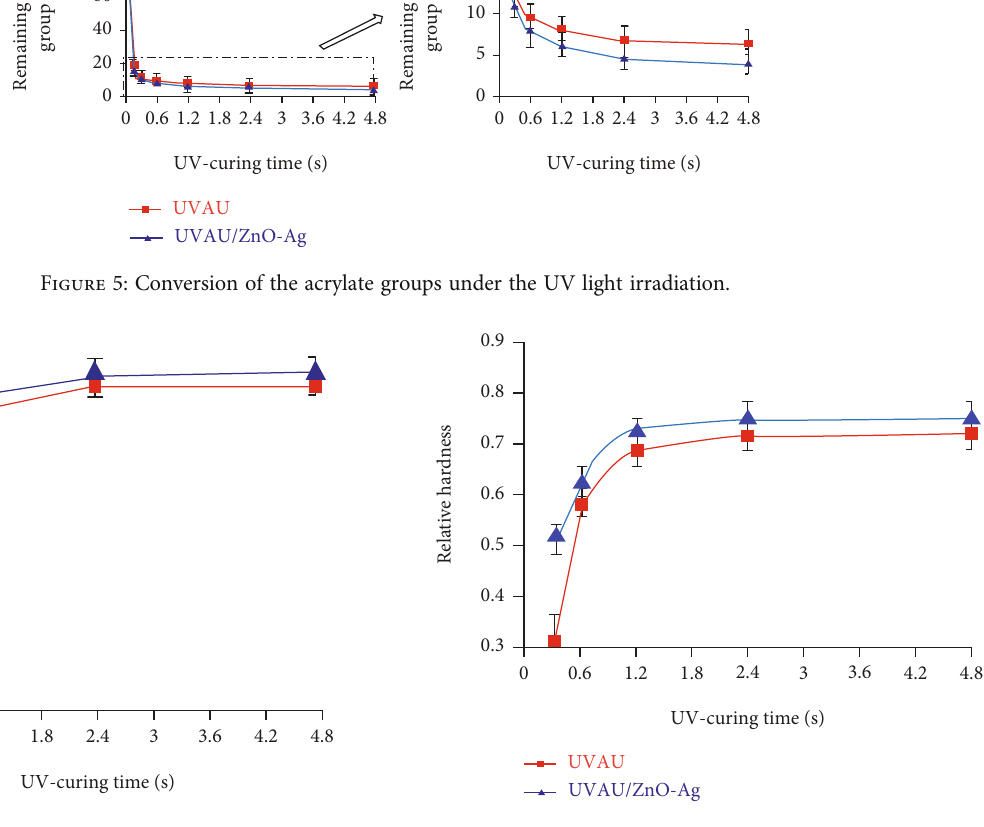
Figure 7: Variation of hardness of the fi lms without (UVAU) and with 2wt% ZnO-Ag nanohybrids (UVAU/ZnO-Ag).